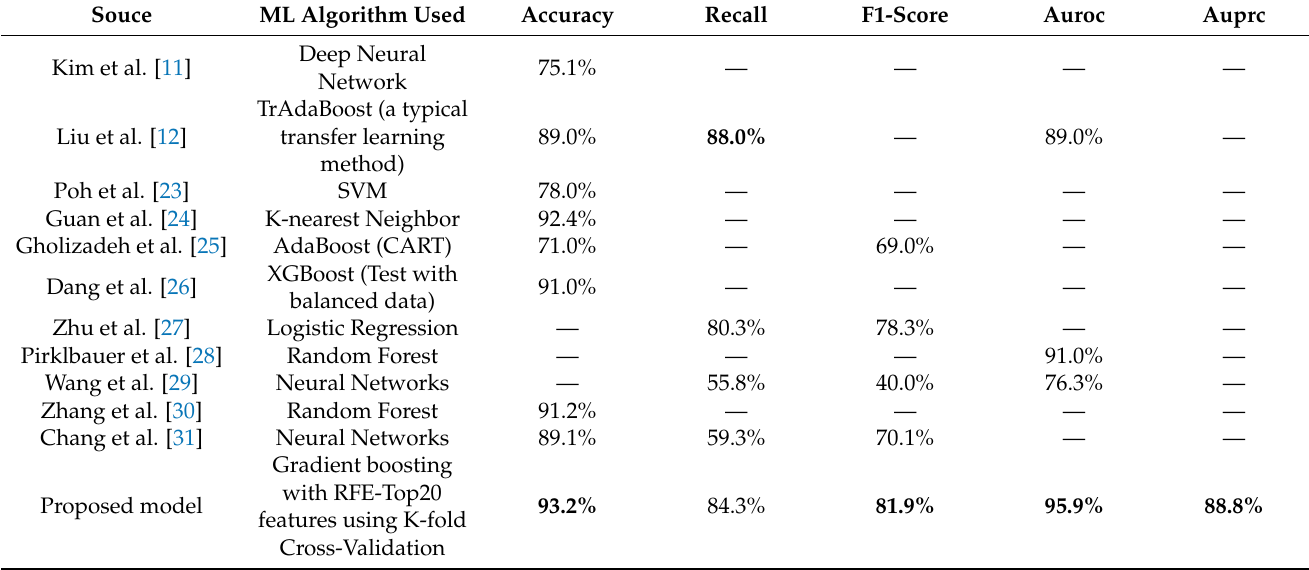
Table 10. Comparison of the performance achieved by the proposed model with existing research.